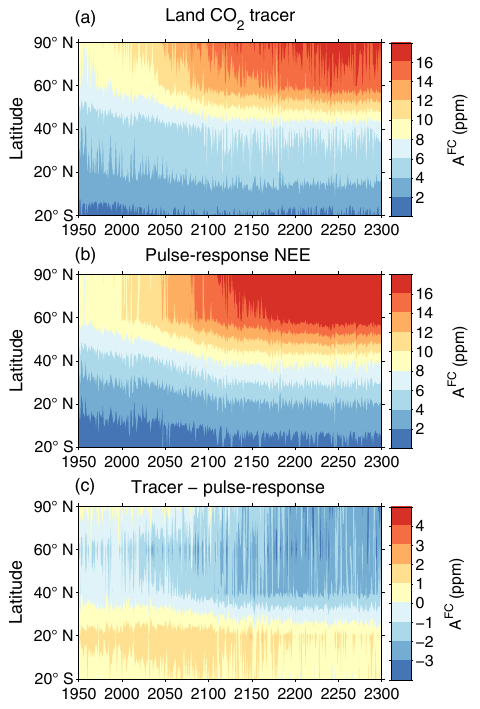
Figure 4. CO 2 annual cycle amplitudes in the FullyCoupled simu- lation derived from (a) the CESM land CO 2 tracer and (b) running NEE from the CLM4 through the pulse-response code. (c) The dif- ference between the land tracer and NEE-derived CO 2 annual cycle amplitudes.